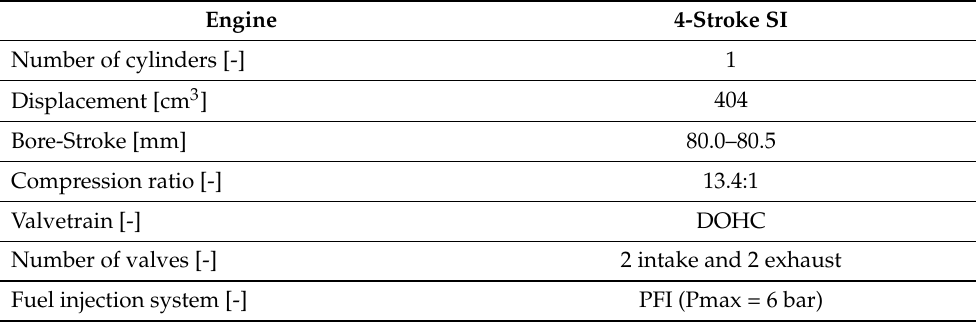
Table 1. Main engine